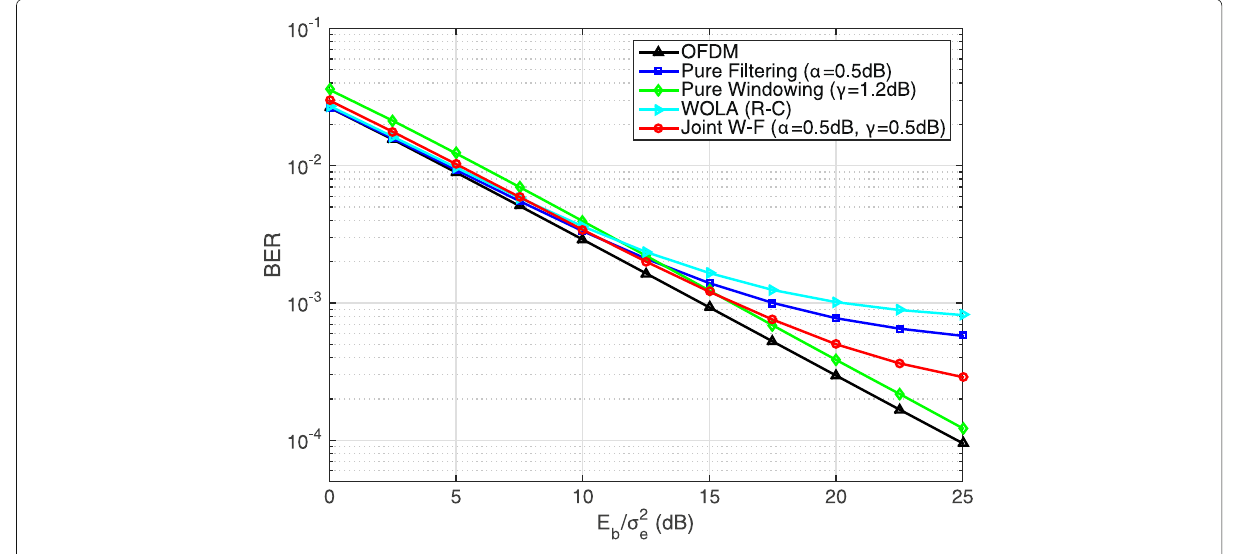
and are asynchronous to the receiver, i.e., the CFOs of the neighboring users are not compensated for. Specifi- cally, the two neighboring users, indexed user 1 and user 2, are allocated to subbands K 1 (cid:2) {− P − η , − P − η − 1, · · · , − 1 − η } and K 2 (cid:2) { P + η , P + η + 1, · · · , 2 P + η − 1 } , respectively. The data symbols of the two users ( 1 ) ( 2 ) are denoted as s [ n ], and s [ n ], respectively. The pre- P P coded data symbols of user l before adding CP are denoted ( l ) ( l ) E T ( K l ) s [ n ] = W H [ n ] , l = 1, 2. The window as u M M P